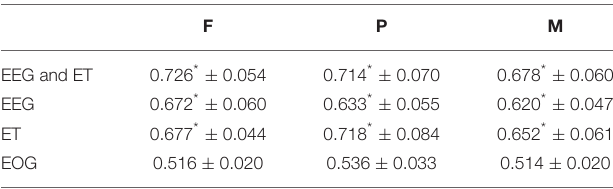
TABLE 1 | Classification results are listed for the different modalities and the three experimental conditions. F P